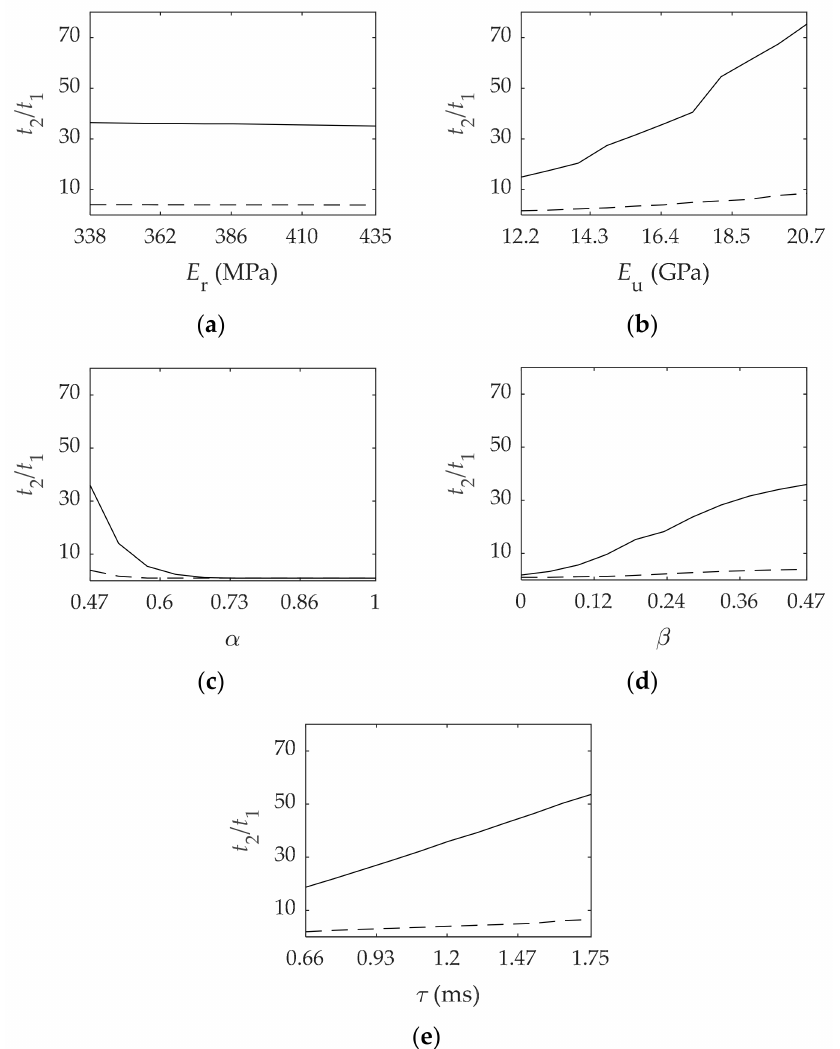
Figure 6. Viscoelastic material parameters influence on the time ratio t 2 / t 1 for the